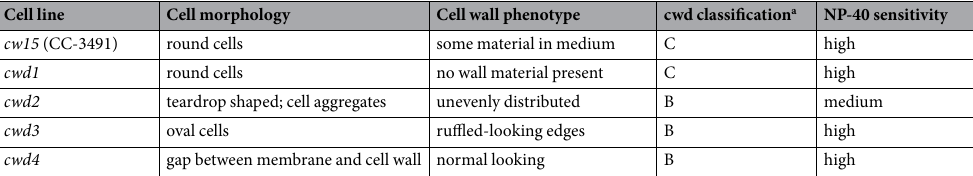
Table 2. Summary of selected cell wall defective mutants. a (A) cells producing normal-looking walls attached